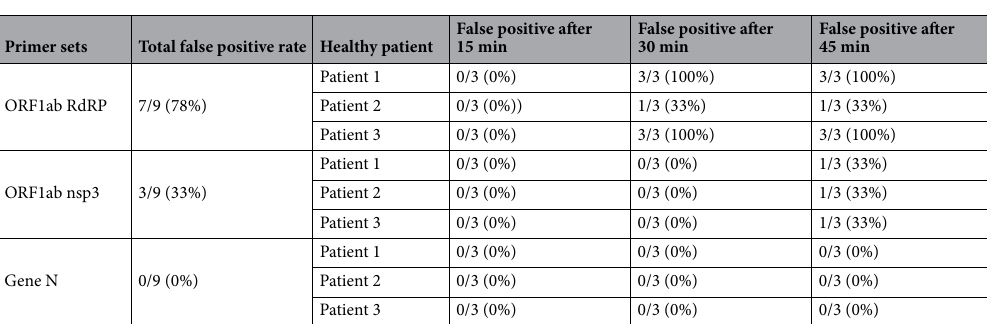
Table 2. Summary of false positives in 3 independent RT-LAMP experiments using saliva samples from healthy patients. Total false positive rate is calculated for a 45 min RT-LAMP reaction on 9 biological repeats (3 patient samples repeated in 3 independent